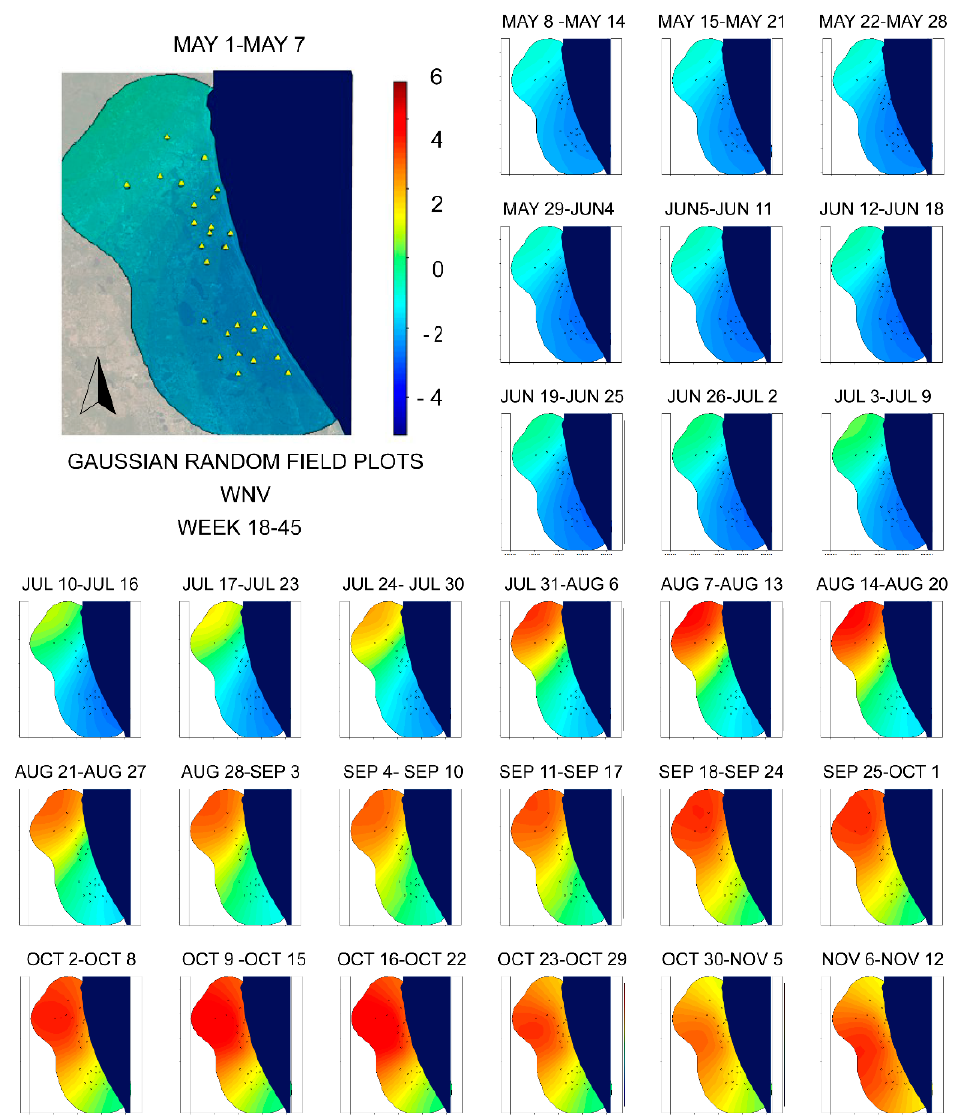
Figure 6. Weekly plots of spatiotemporal Gaussian random fields (GRF) for week 18–45 2018 WNV sentinel chicken seroconversion rates. A convex hull was generated to create the GRFs, and the GRFs were clipped to the coastline for visualization. The ESRI background imagery was used to map the first plot (1–7 May).